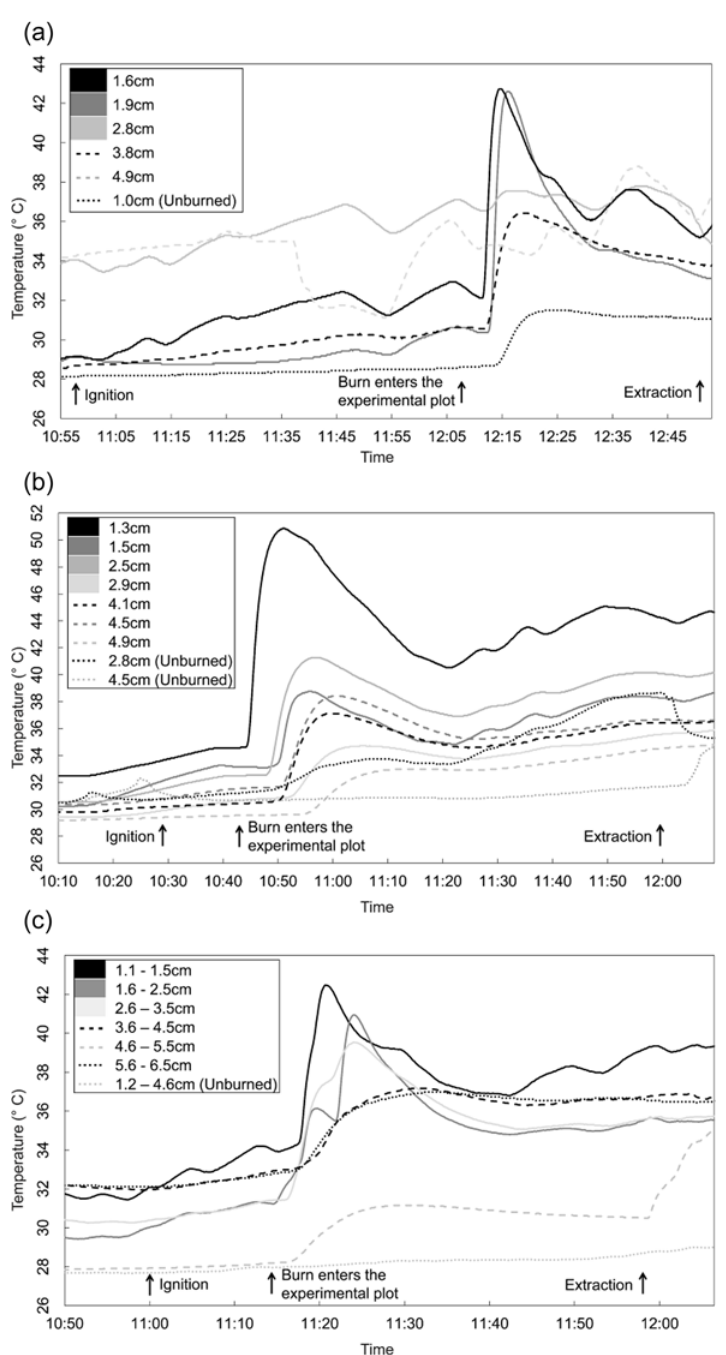
Fig 3. Soil temperatures as measured with iButton thermocrons during controlled burning at the Ordway-Swisher Biological Station, Putnam County, Florida, July 2012. (a) 5 th , (b) 6 th , (c) 26 th , averaged soil